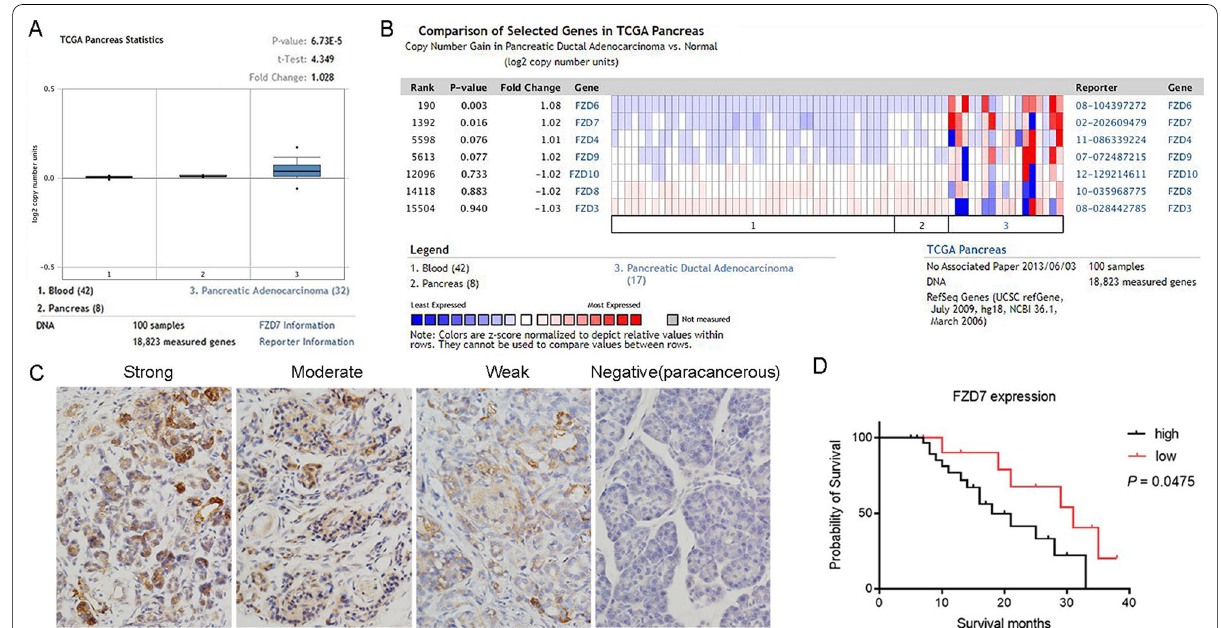
Fig. 1 Querying the ONCOMINE database showed that FZD7 expression was significantly higher in pancreatic adenocarcinoma compared with normal pancreatic tissue, a representative result is shown in ( A ); among the different Frizzled Receptors, FZD7 was significantly over-expressed in pancreatic ductal adcarcinoma compared with other Frizzled receptors ( B ). FZD7 expression in cancer tissues was detected in PDAC tissue samples by IHC, which stained darker than paracancerous tissues ( C ). Kaplan–Meier assay showed that high expression of FZD7 was associated with low survival probability, P < 0.05 ( D